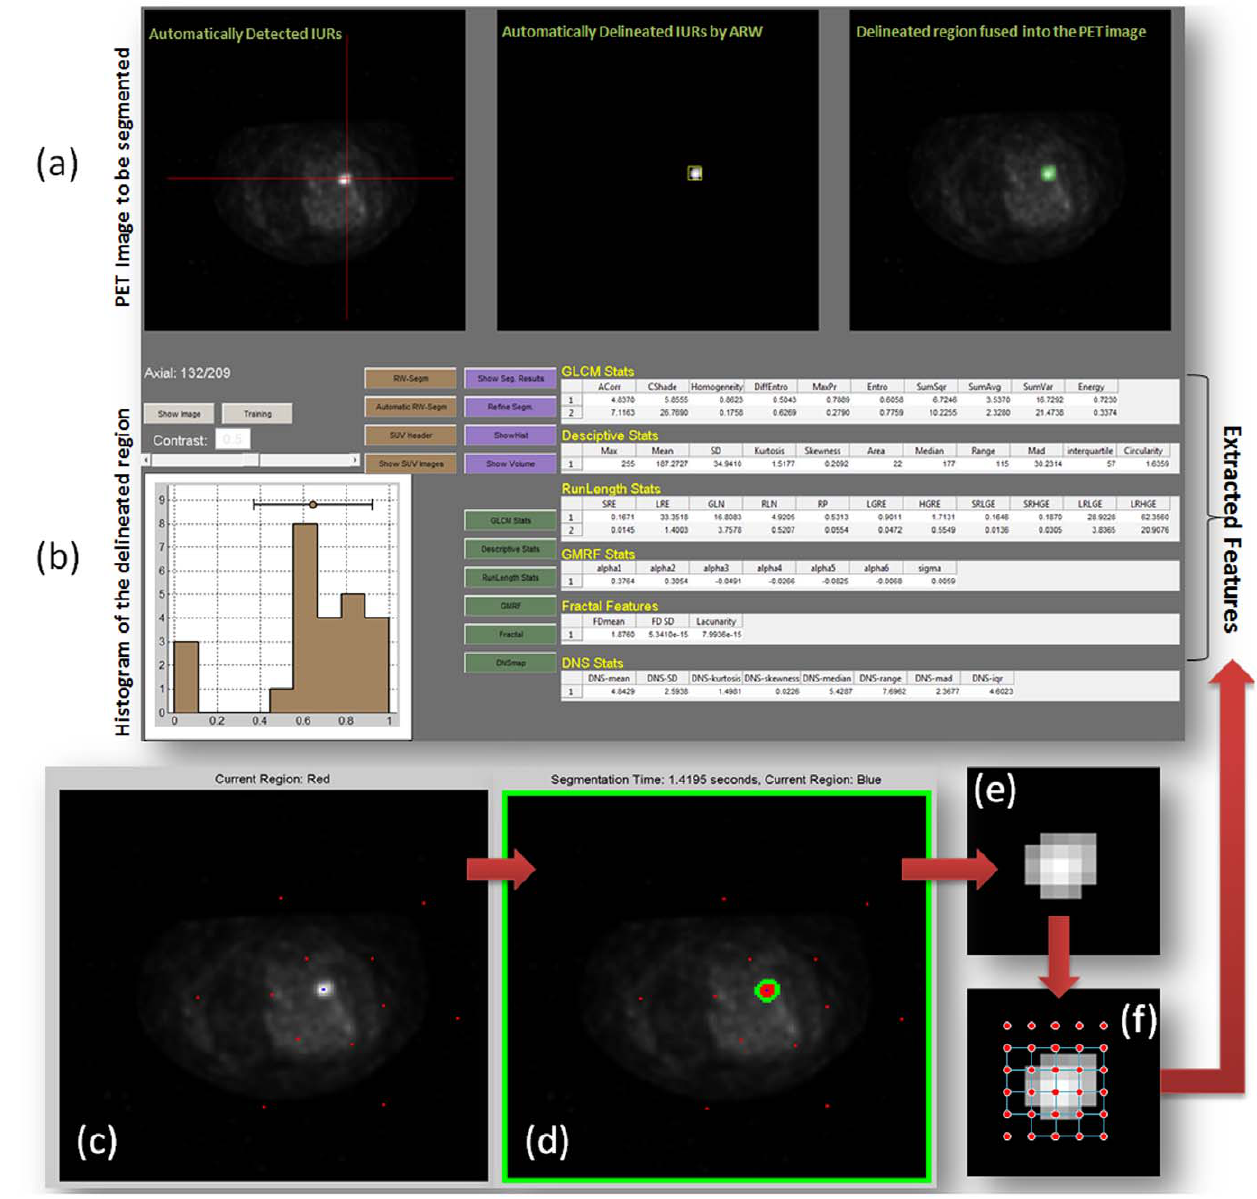
Figure 2. An example view from our proposed framework/software is shown. (a) Automatically detected uptake regions (first), its segmented version (second), and fusion of segmented region into original image (third) are shown. After detection, the details of object (blue) and background (red) seeding and conducted segmentation are shown in (c) and (d), respectively. Segmented region (e) is divided into local windows and for each local window pre-defined textural and shape features are extracted (f). Tools to control extraction of textural features, segmentation, SUV analysis, and the immediate results are shown in (b).